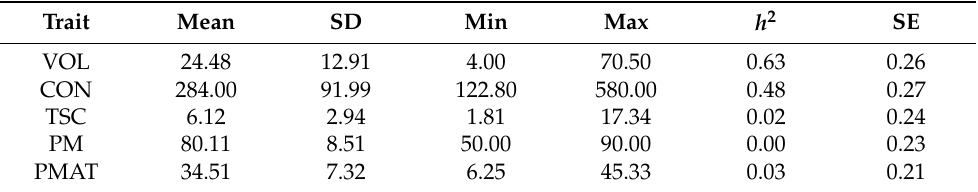
VOL: gel-free volume (ml), CON: sperm concentration in the gel-free volume (10 6 spermatozoa/ml), TSC: total sperm count (10 9 spermatozoa) = gel-free volume × sperm concentration, PM: progressive motility [%],